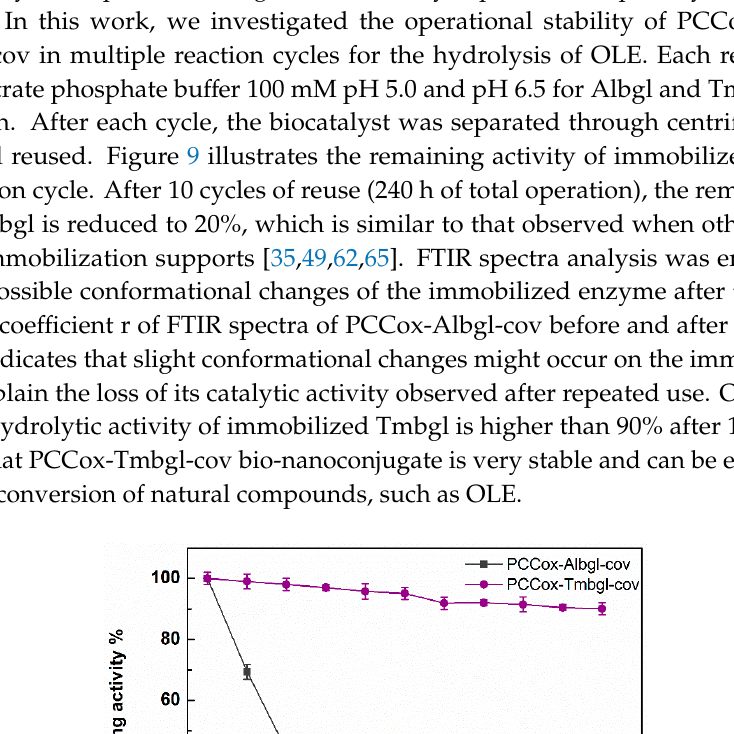
Figure 8. ( a ) Hydrolysis of OLE catalyzed by immobilized β -glucosidase at different time intervals. The amount of the enzyme in the reaction system was 0.15 mg/mL and 0.07 mg/mL for Albgl and Tmbgl respectively. ( b ) Reaction progress of the enzymatic hydrolysis of OLE catalyzed by PCCox-Tmbgl-cov and the formation of HT at different time intervals (the standard deviation was less than 5% in all cases).